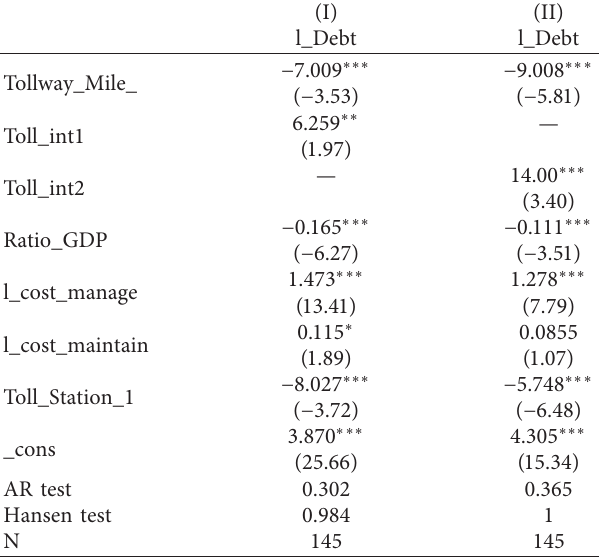
Table 9: Parameter estimation